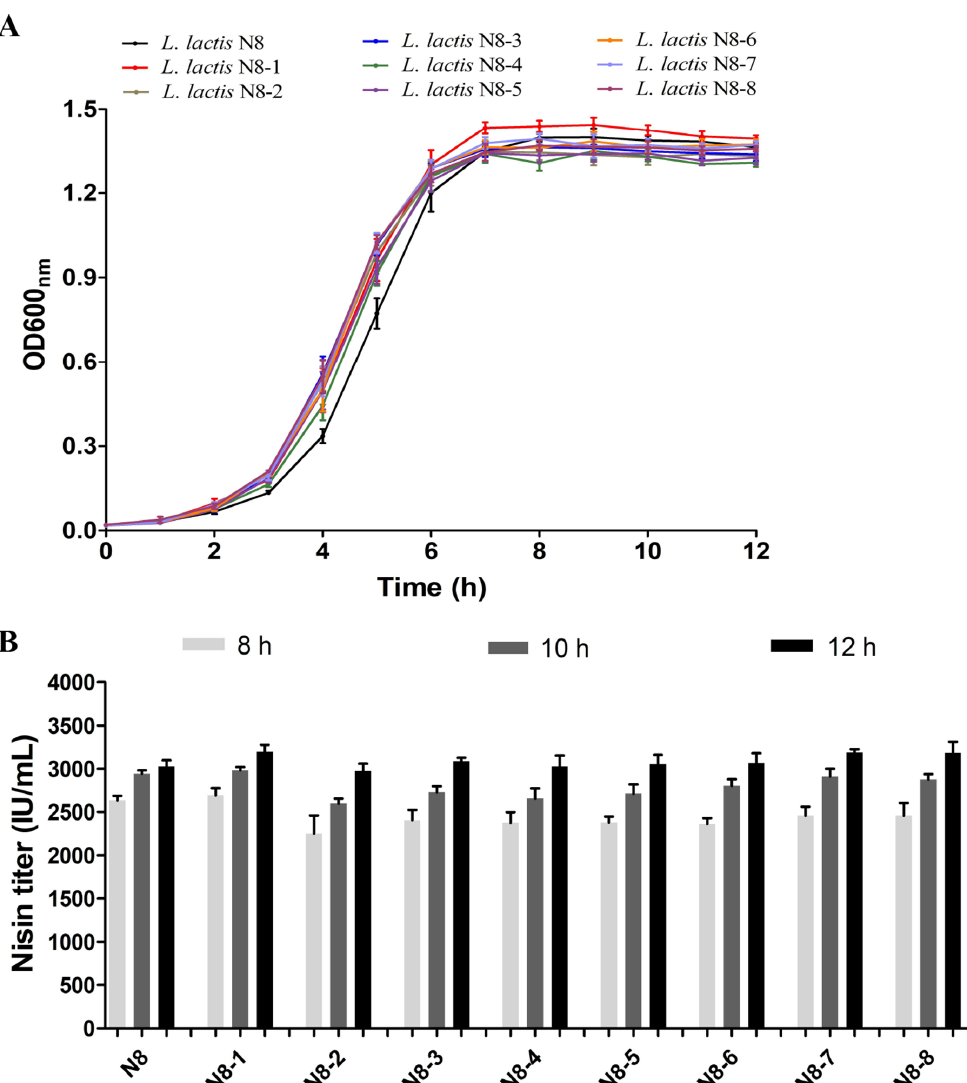
Figure 9. Phenotypes of wild-type strain and streamlined genome chassis strains. ( A ) Growth profiles s of the strains. ( B ) Nisin titer of different strains at different time points (8 h, 10 h and 12